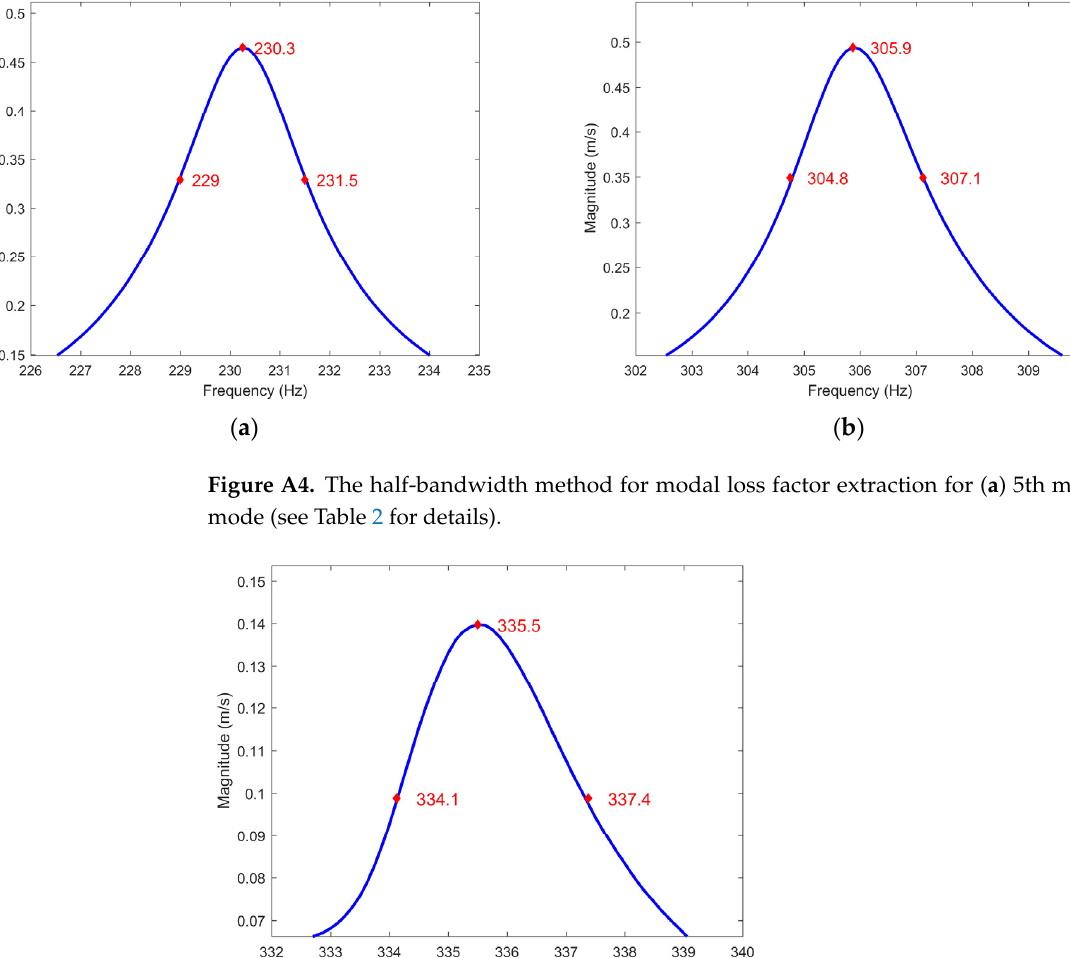
Figure A3. The half-bandwidth method for modal loss factor extraction for ( a ) the third mode and ( b ) the fourth mode (see Table 2 for details).